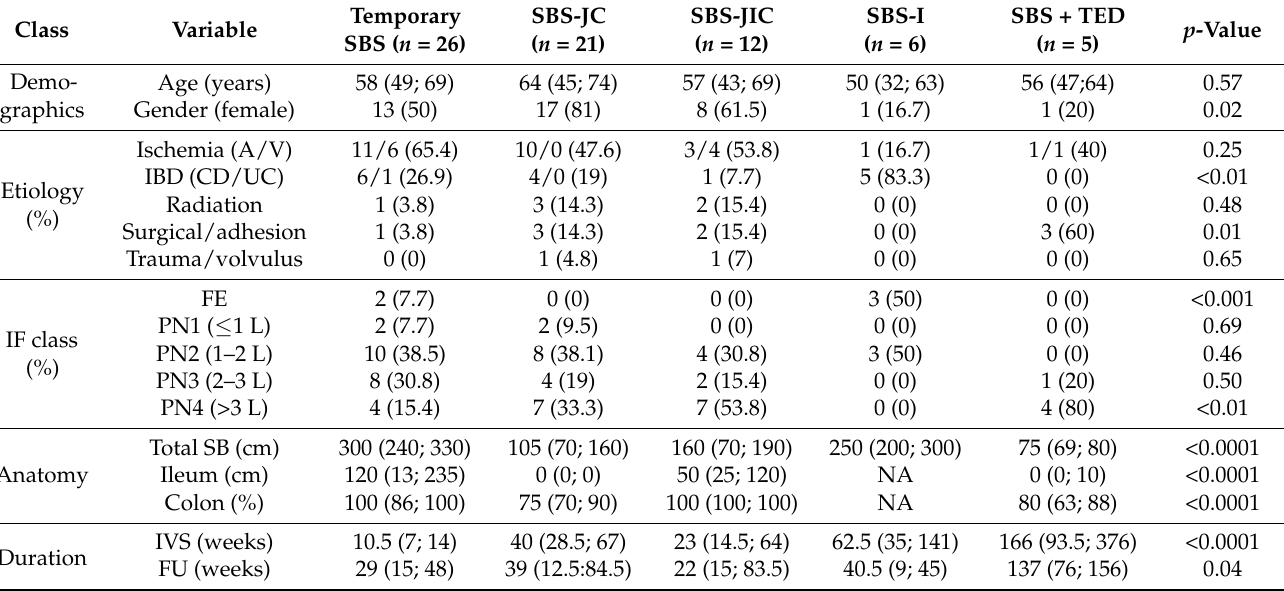
Table 2. Demographics and clinical characteristics of SBS